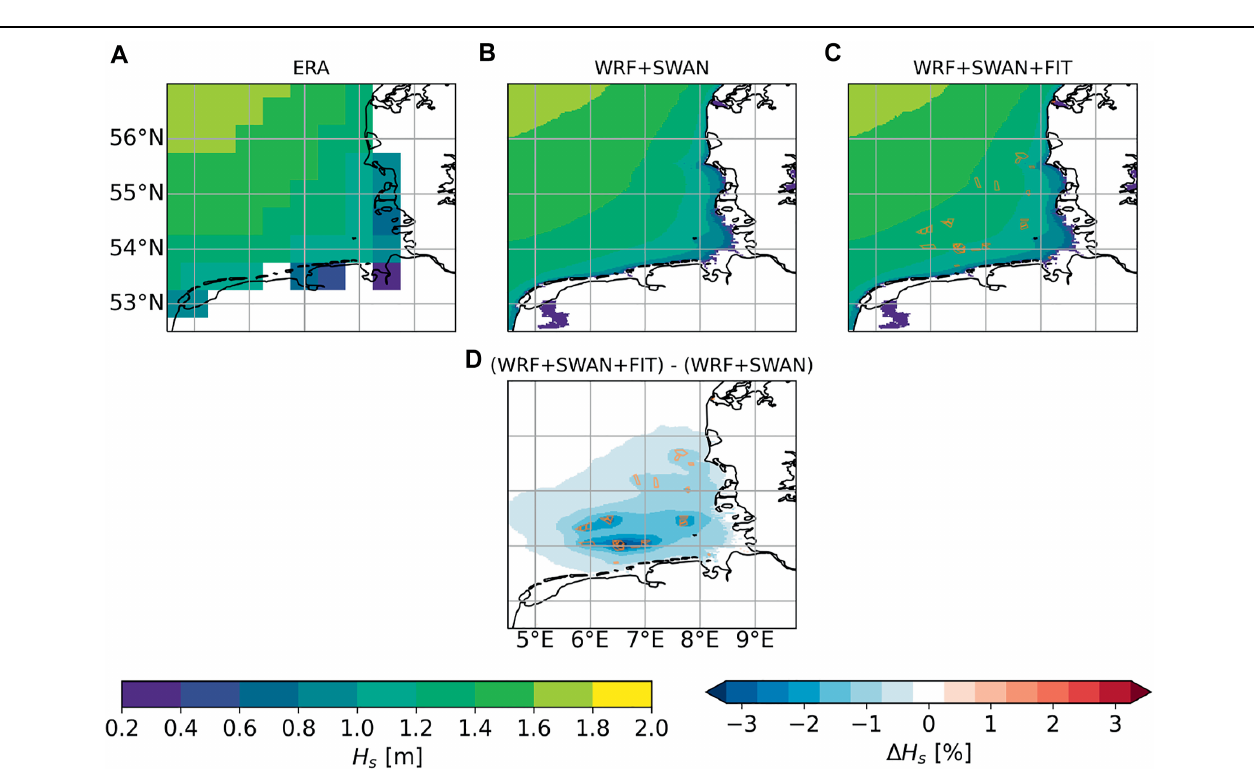
FIGURE 13 | (A) Long-term significant wave height ( H s ) from ERA5 and simulated by (B) WRF + SWAN and (C) WRF + SWAN + FIT. (D) Relative reduction on significant wave height from (WRF + SWAN + FIT)-(WRF + SWAN) normalized by (WRF + SWAN).